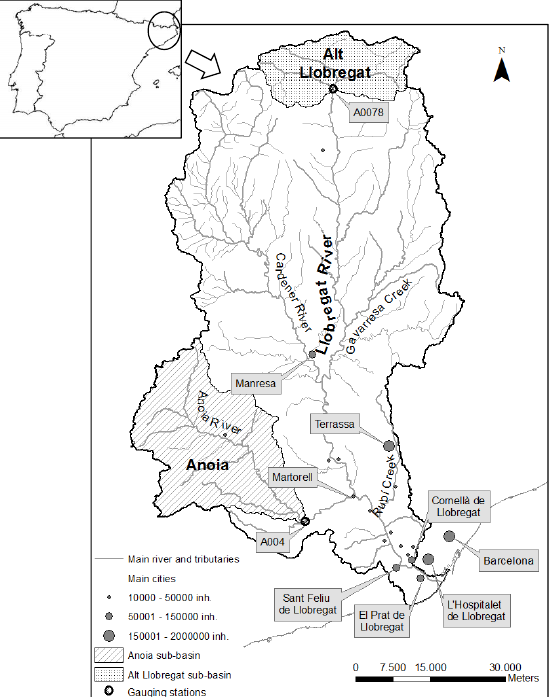
Figure 1 Location of the Llobregat River basin. 2 Fig. 1. Location of the Llobregat River